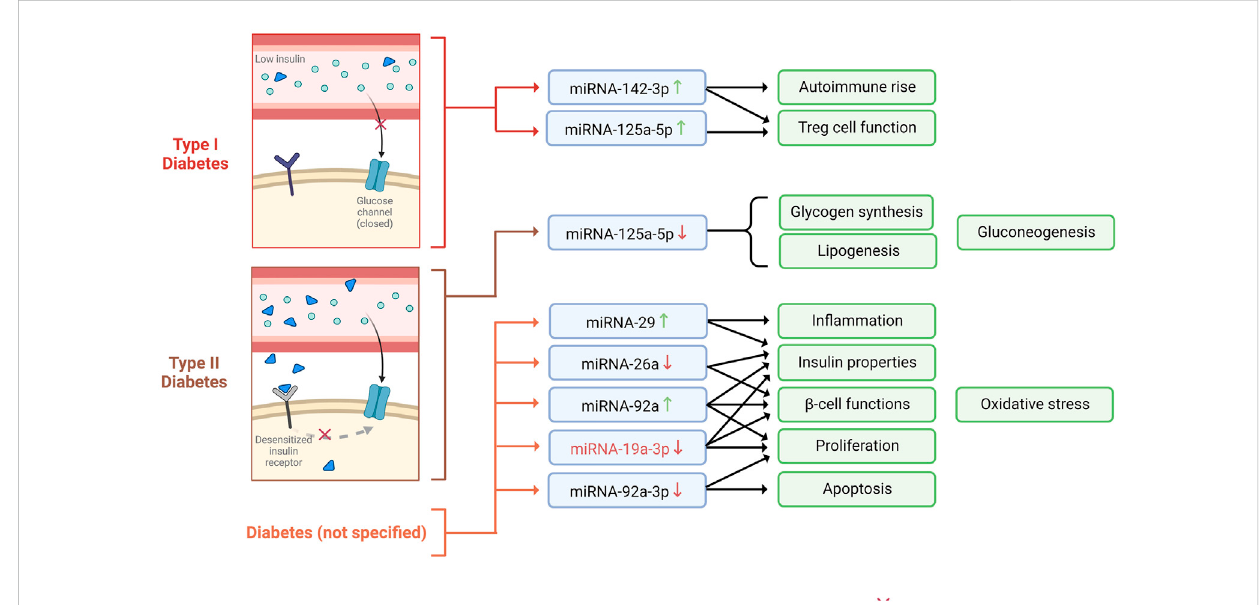
Dysregulation of miRNA expression pro fi les in Hashimoto ’ s thyroiditis and Grave ’ s disease, and the biological mechanism